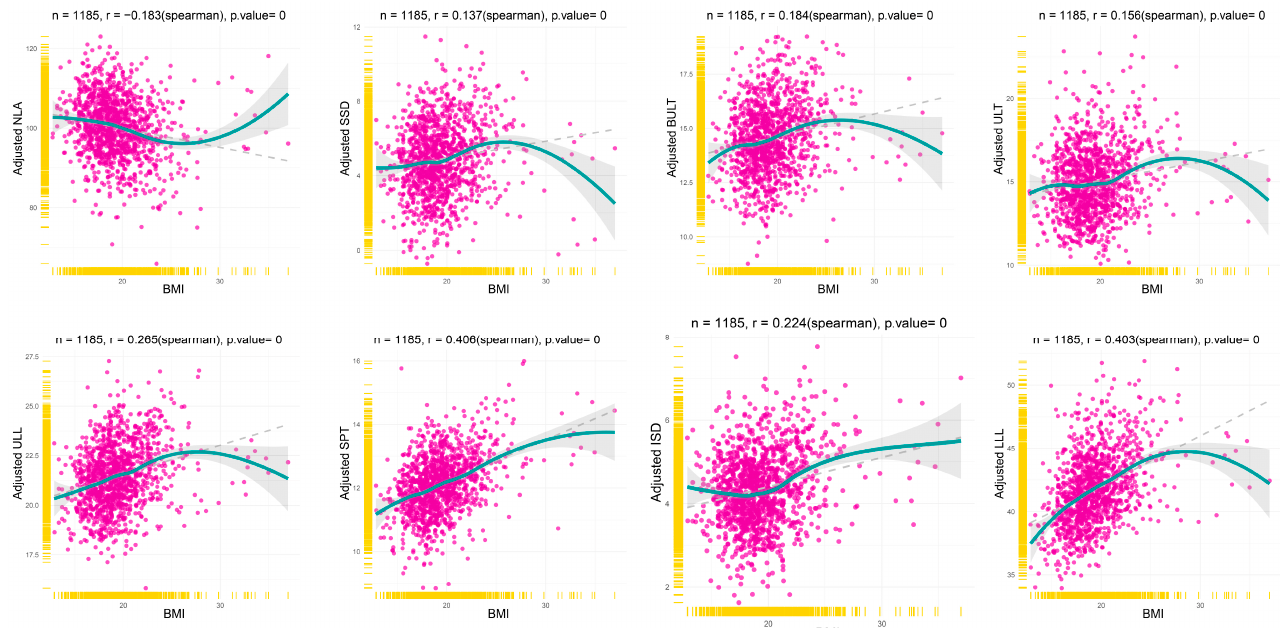
Figure 4. The relationships between the adjusted eight lip characteristics and BMI. The solid blue line fitted by the Loess function reveals the true variation tendency of lip characteristics according to the BMI, and the grey dashed lines fitted by the lm function reveal the general trend. NLA: Nasolabial angle, SSD: Superior sulcus depth, BULT: Basic upper lip thickness, ULT: Upper lip thickness, ULL: Upper lip length, SPT: Soft pogonion thickness, ISD: Inferior sulcus depth, LLL: Lower lip length, BMI: Body mass index.